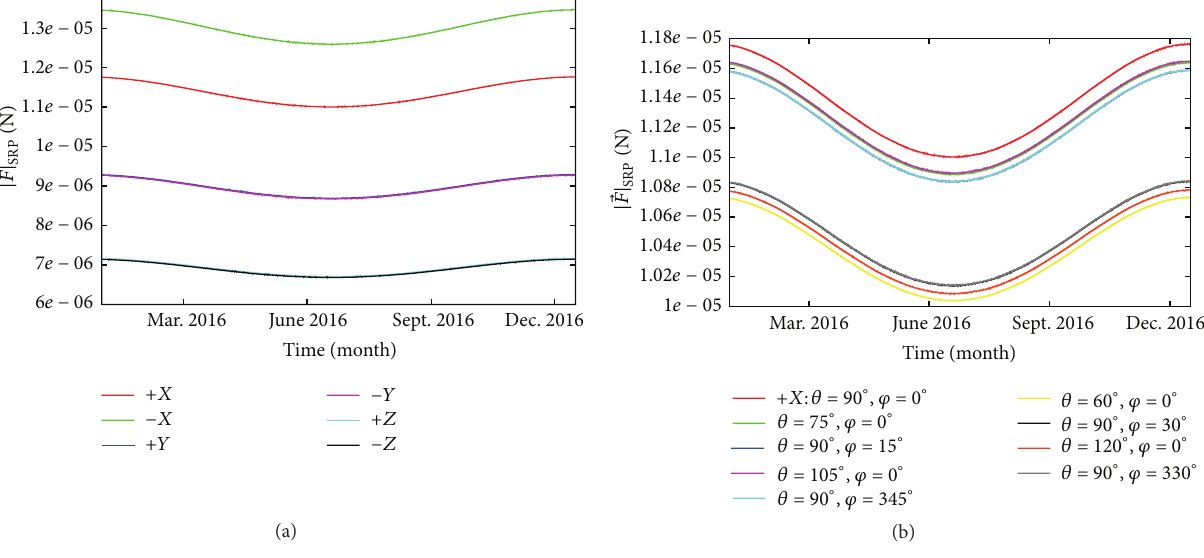
Figure 8: Absolute value of disturbance force due to SRP for different illumination conditions depicted over one year. (a) Perpendicular solar irradiation of each satellite side. (b) Illumination conditions estimated for MICROSCOPE.